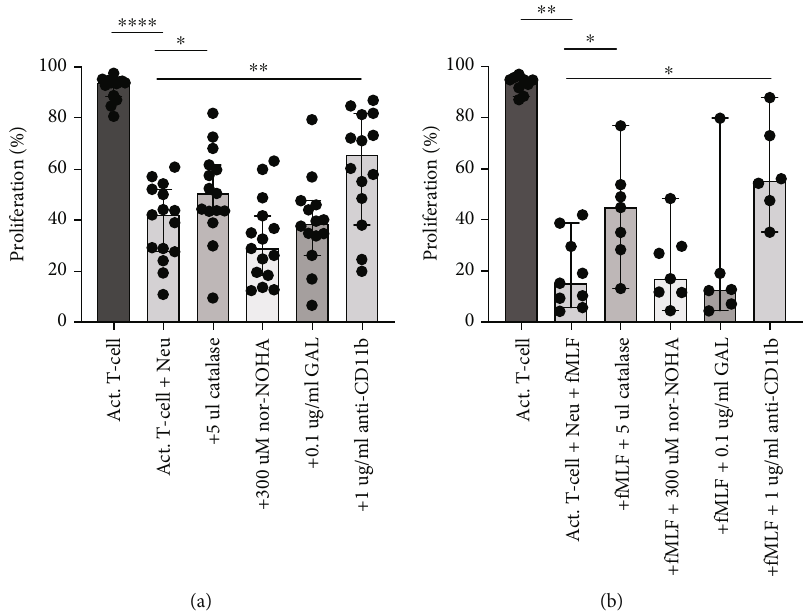
Figure 1: Inhibition of T-cell proliferation by NDGs and the e ff ect of catalase, nor-NOHA, GAL, and CD11b on proliferation restoration. (a) Inhibition of T-cell proliferation by nonactivated NDGs ( n = 15 ). Neutrophils suppress T-cell proliferation ( p < 0 : 001 ), and addition of ROS inhibitor catalase protects T-cell proliferation ( p = 0 : 048 ). The arginase inhibitor nor-NOHA did not have a protective e ff ect and neither did TGF- β inhibitor GAL. Addition of anti-CD11b antibody protected T-cell proliferation ( p = 0 : 0040 ). (b) Inhibition of T-cell proliferation by fMLF activated NDGs ( n = 9 ). fMLF activated NDGs inhibit T-cell proliferation ( p = 0 : 0039 ), and the proliferation was improved by catalase ( p = 0 : 016 ) and anti-CD11b ( p = 0 : 031 ). nor-NOHA and GAL did not improve proliferation. Graphs indicate median with 95% CI, and statistical signi fi cance was tested using Wilcoxon matched pairs signed rank test.